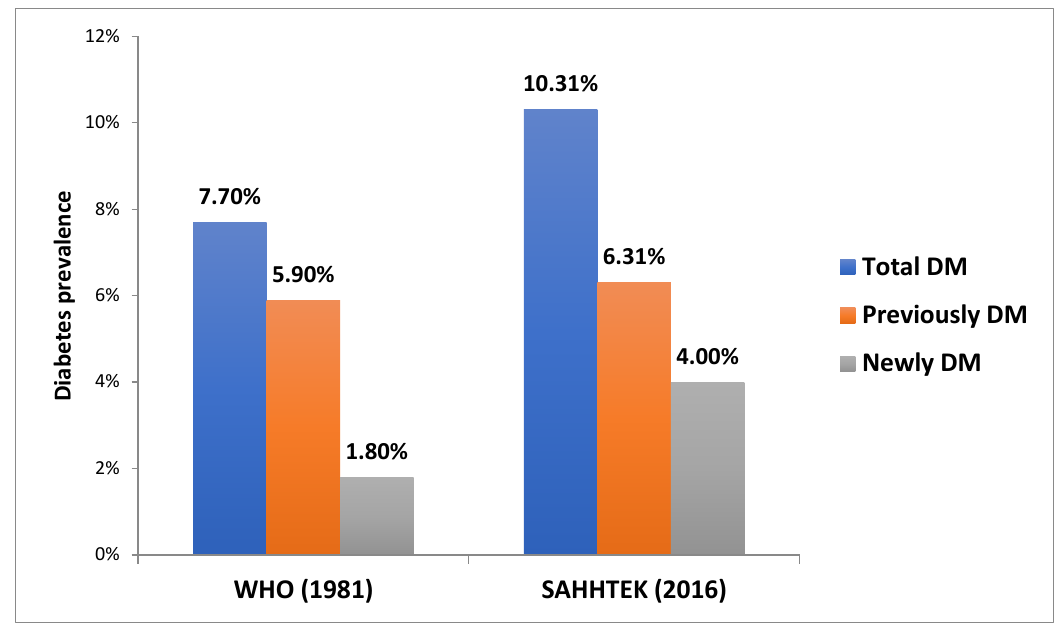
Figure 1. Comparison between the diabetes prevalence rate amongst the WHO 1981 and SAHHTEK 2014